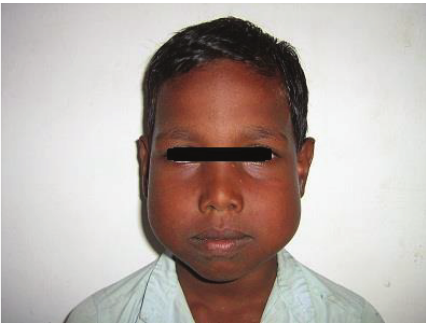
Figure 1: Facial view showing bilateral swelling of mandible.